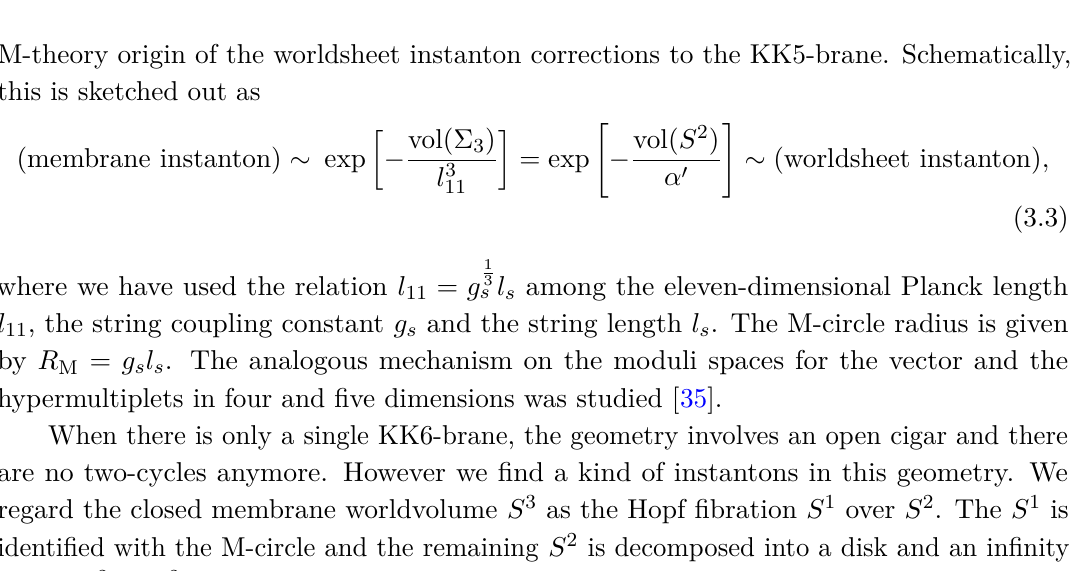
Table 1 . The configuration of Euclidean M2-brane wrapping on the M-circle S 1 and S 2 in the KK6 geometry. The worldvolume and the isometry directions are denoted as × and ◦ , respectively. The lower table is the corresponding configuration in ten-dimensional type IIA